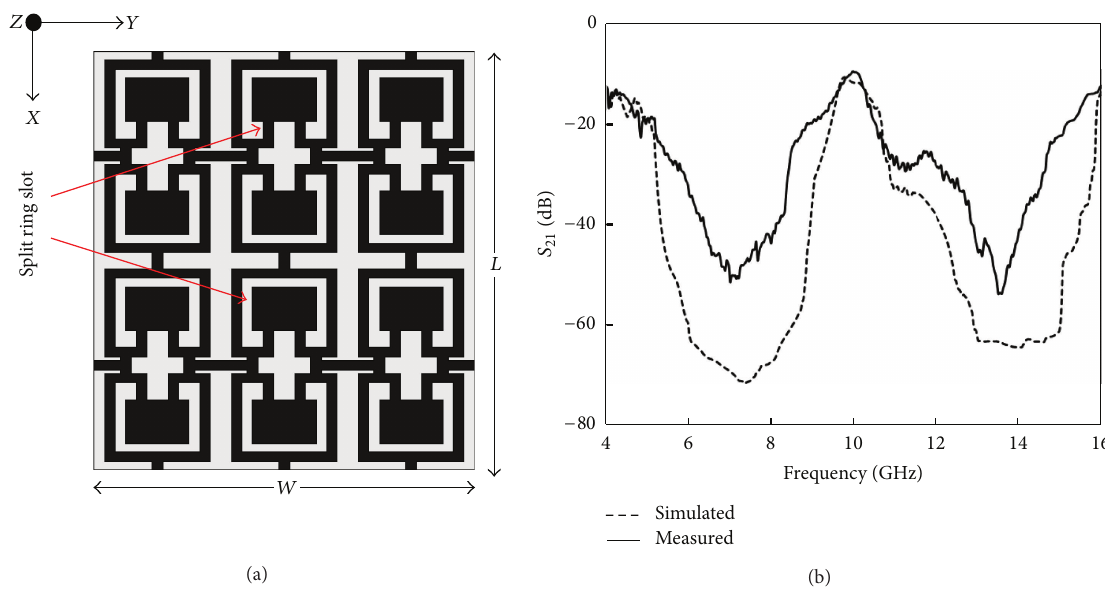
Figure 11: Dual-band SRS-EBG: (a) EBG structure and (b) transmission responses ( 𝑆 21 ).